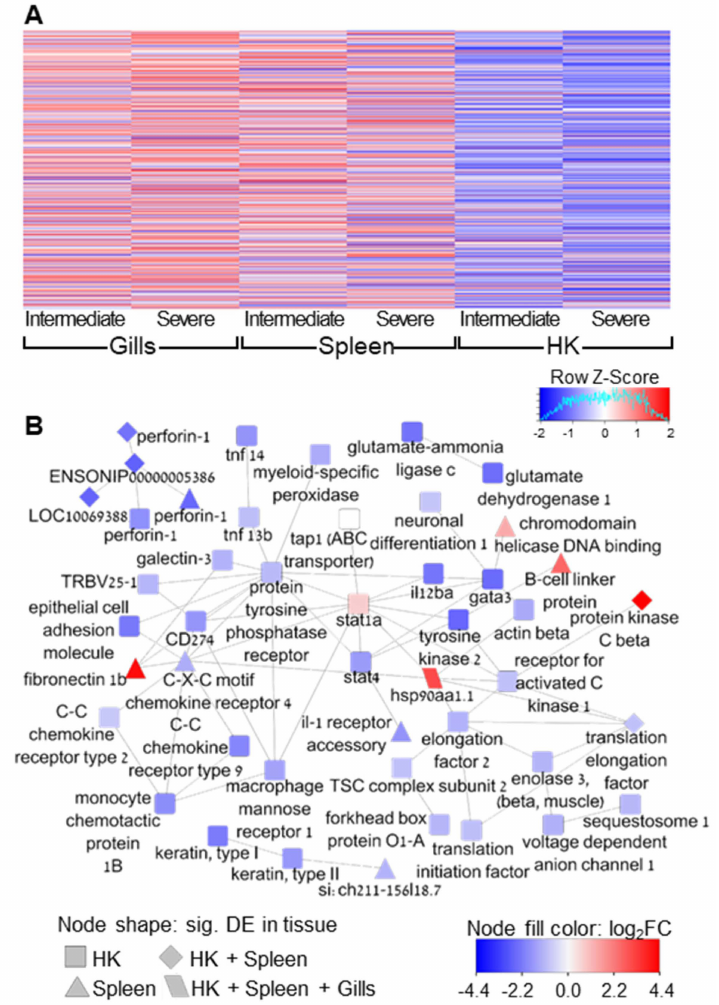
Figure 6. Expression patterns of immune-related genes and network analysis. ( A ) Heat map showing hierarchical clustering of gene expression patterns (log2FC) in the three tissues at intermediate and severe infection stages (up-regulated, red; down-regulated, blue). ( B ) Network of significantly differentially expressed genes based on protein interactions (STRING database). Node fill is color- scaled according to log2 FC (up-regulated, red; down-regulated, blue) and node shape indicates the tissue, as the legend details. See Supplementary Table S6 for additional details of the genes